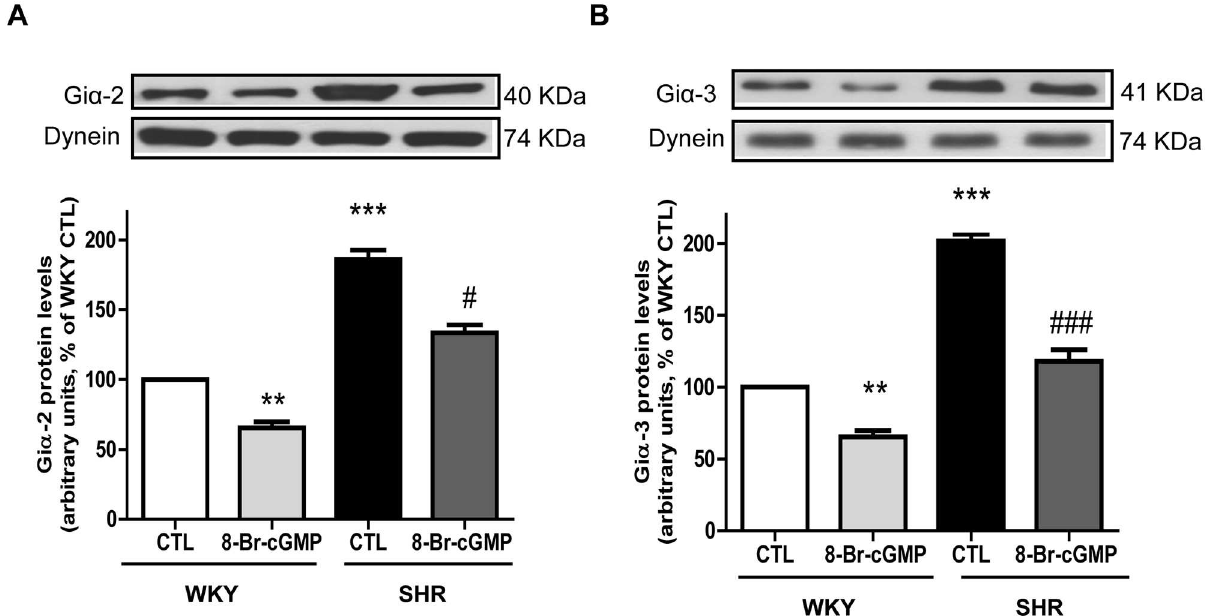
Fig 2. The effect of 8-Br-cGMP on the Gi α protein expression in the aortic vascularsmooth muscle cells (VSMC) from 12-weekold spontaneously hypertensive rats (SHRs) and age-matched Wistar-Kyoto (WKY) rats. ConfluentVSMCs were starved 24 h and incubatedin the absence(control) or presenceof or 8-Br-cGMP (0.5mM) for 24 h. The cell lysates were preparedand subjectedto Western blot analysisusing specific antibodies againstGi α -2 (A) and Gi α -3(B)) or dynein as loadingcontrol, (upper panel)as describedin the Materials and methods. Quantificationof protein bands was done by densitometric scanning(lower panel). The results are expressedas a percentageof the WKY control (CTL), taken as 100%. Valuesare the mean ± SD of 4 separateexperiments using different cell populations from different animals. ** P < 0.01, *** P < 0.001vs WKY CTL group, # P < 0.05, ### P < 0.001vs SHR CTL group.